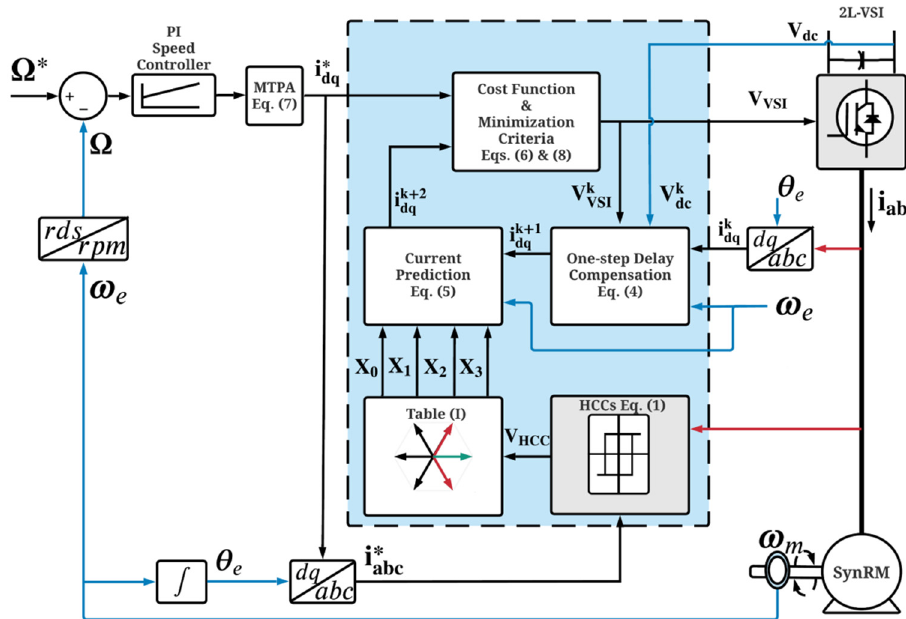
Figure 2. Block diagram of the HCC–MPCC.